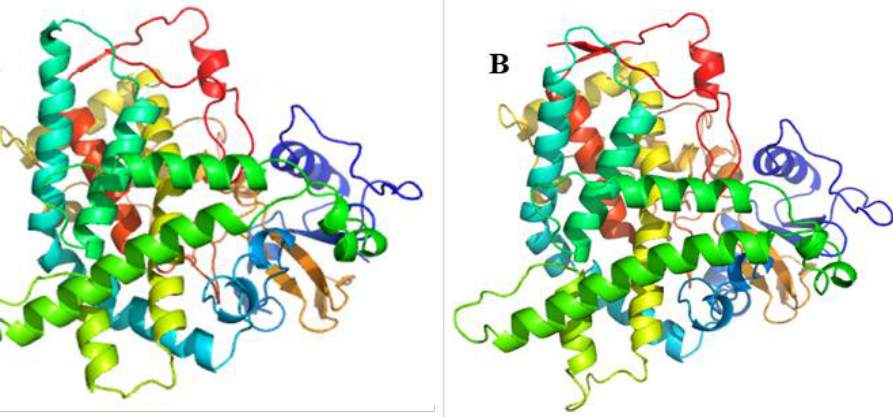
Figure A5. Predicted 3D structures of ( A ) Xs GAO1 and ( B ) Xs GAO2.